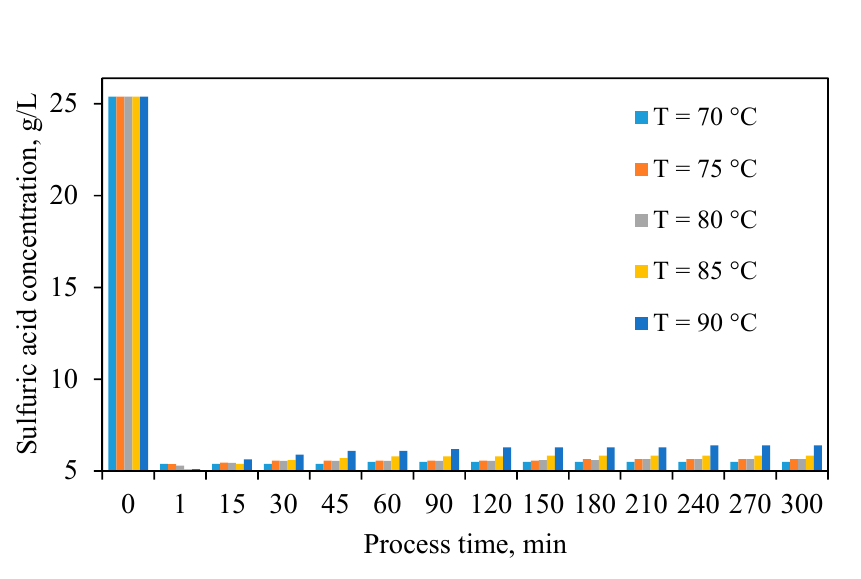
Figure 2. Changes in the concentration of sulfuric acid during leaching experiments.